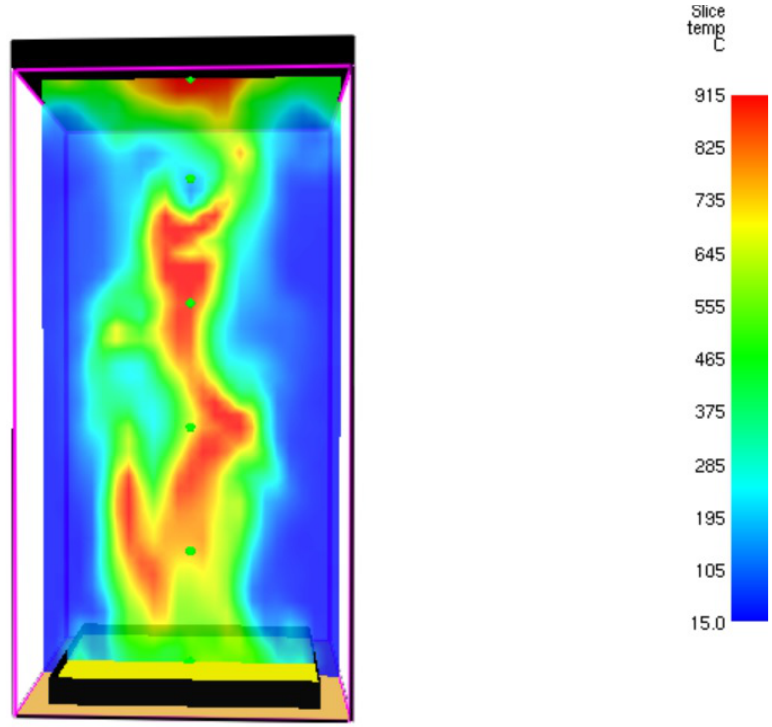
Figure 18. Temperature field (°C) inside the burner at t = 80.5 s.